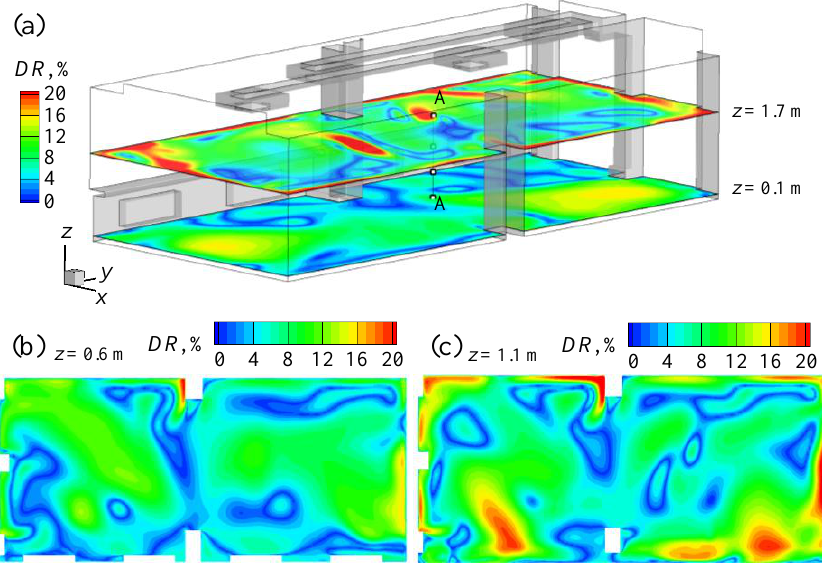
Figure 9. Unsteady RANS (URANS)-obtained instantaneous distributions of DR values at four cross-sections of the room (data for θ = 25°, case #2).